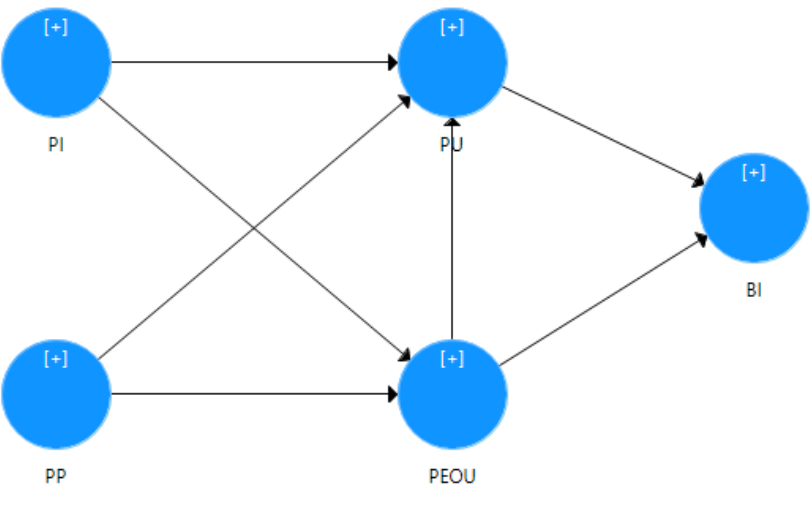
Figure 7. Research model flow.